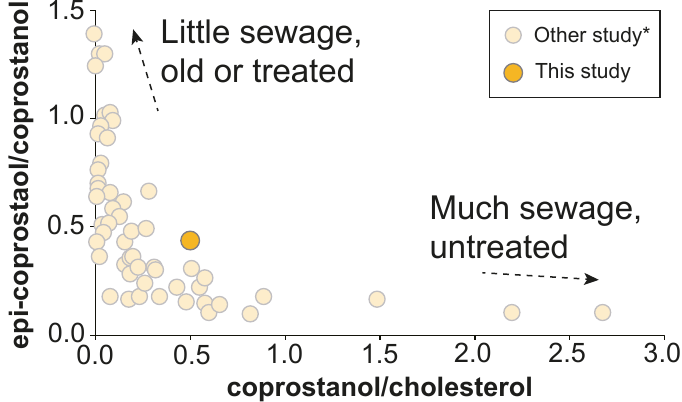
Figure 7. A biplot of the coprostanol / cholesterol ratio with the epicoprostanol / coprostanol ratio for the Yatsu sediment. Our data is plotted on a redrawn figure from Mudge and Seguel [54] and Mudge and Ball